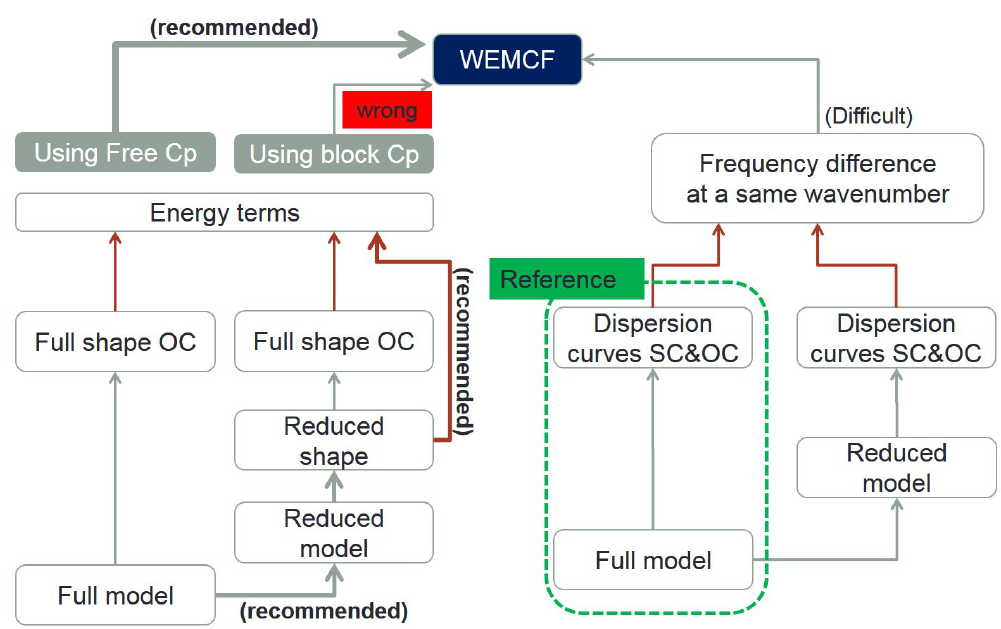
Figure 3. Illustration of different paths for the calculation of WEMCF in the framework of